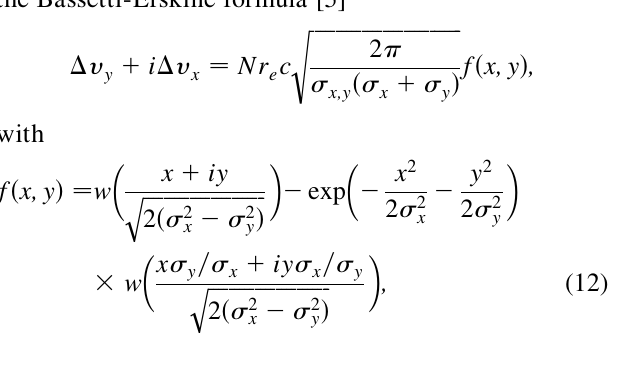
TABLE I. KEKB-LER parameters used in the simulation.